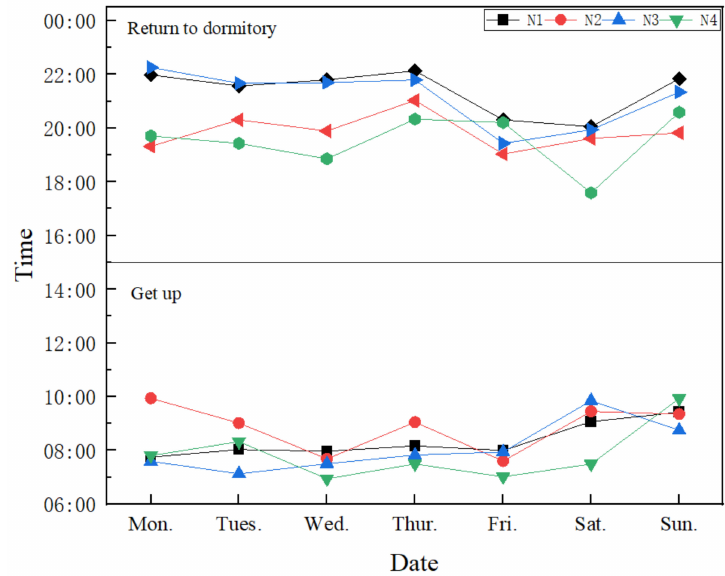
Figure 23. Study time